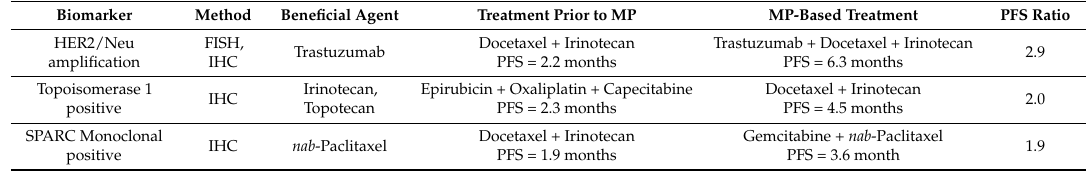
Table 5. Progression-free survival on molecular profile-matched therapy vs. on prior